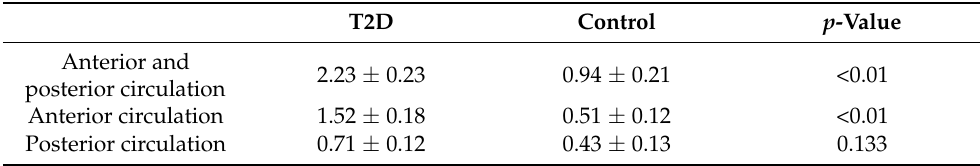
Figure 1. T1-weighted three dimensional vessel wall imaging (3D-VWI) in type 2 diabetes mellitus (T2D) patients and a control. ( A ) A 59-year-old man with T2D had wall thickening at left MCA with high signal indicating atherosclerotic plaque, visualized by curved planar reformation (CPR) (arrow) and axial-sectional view (triangle). ( B ) A 56-year-old woman with T2D showed wall thickening at right VA with a high signal indicating atherosclerotic plaque, visualized by CPR (arrow) and axial-sectional view (triangle). ( C ) No plaques were detected in a 58-year-old woman from the control group, visualized by CPR (arrow) and axial-sectional view at indicated location by arrow. Table 3. Mean number of intracranial plaques per